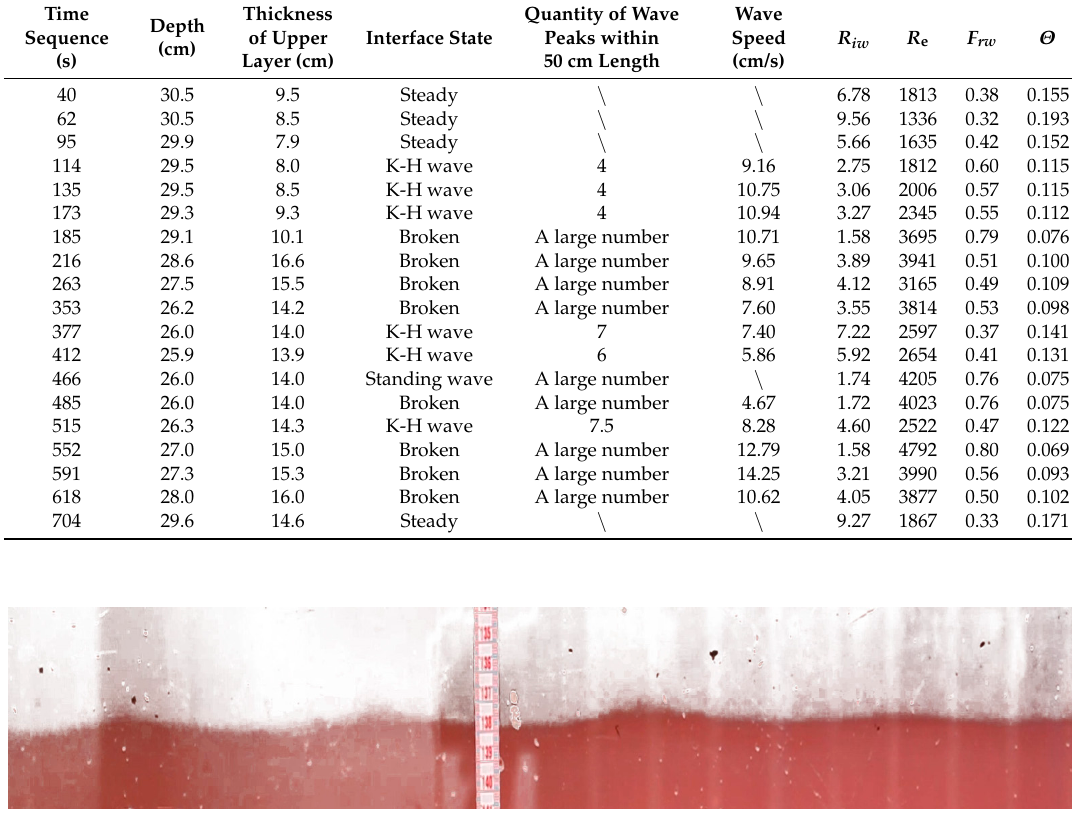
Table 4. The characteristic parameters at the 40 m section of the flume.